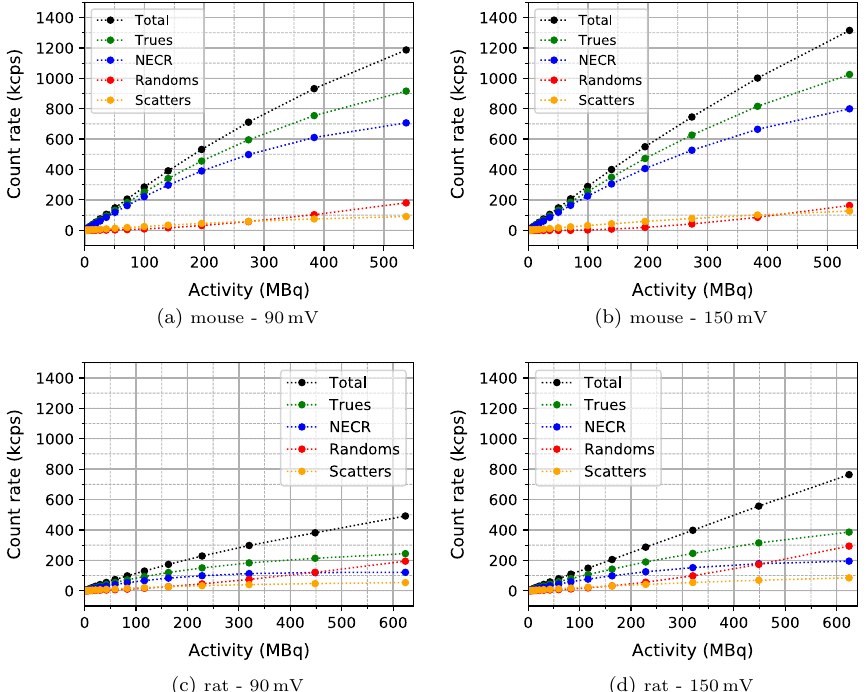
Fig. 3 Count rate results for ( a ) the mouse scatter phantom, with relative timing threshold of 90 mV, ( b ) the mouse scatter phantom, with relative timing threshold of 150 mV, ( c ) the rat scatter phantom, with relative timing threshold of 90 mV and ( d ) the rat scatter phantom, with relative timing threshold of 150 mV. The highest activity for the mouse scatter phantom, 537 MBq, corresponds to an activity concentration of 2690 MBq/ml. The highest activity for the rat scatter phantom, 624 MBq, corresponds to an activity concentration of 1390 MBq/ml